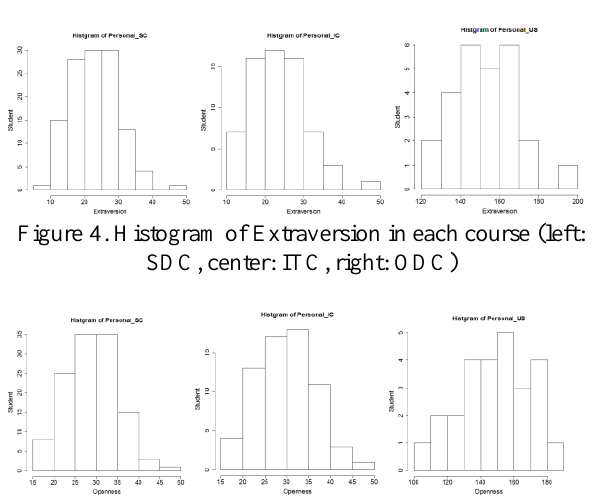
Figure 3. Histogram of Neuroticism in each course (left: SDC, center: ITC, right: ODC)